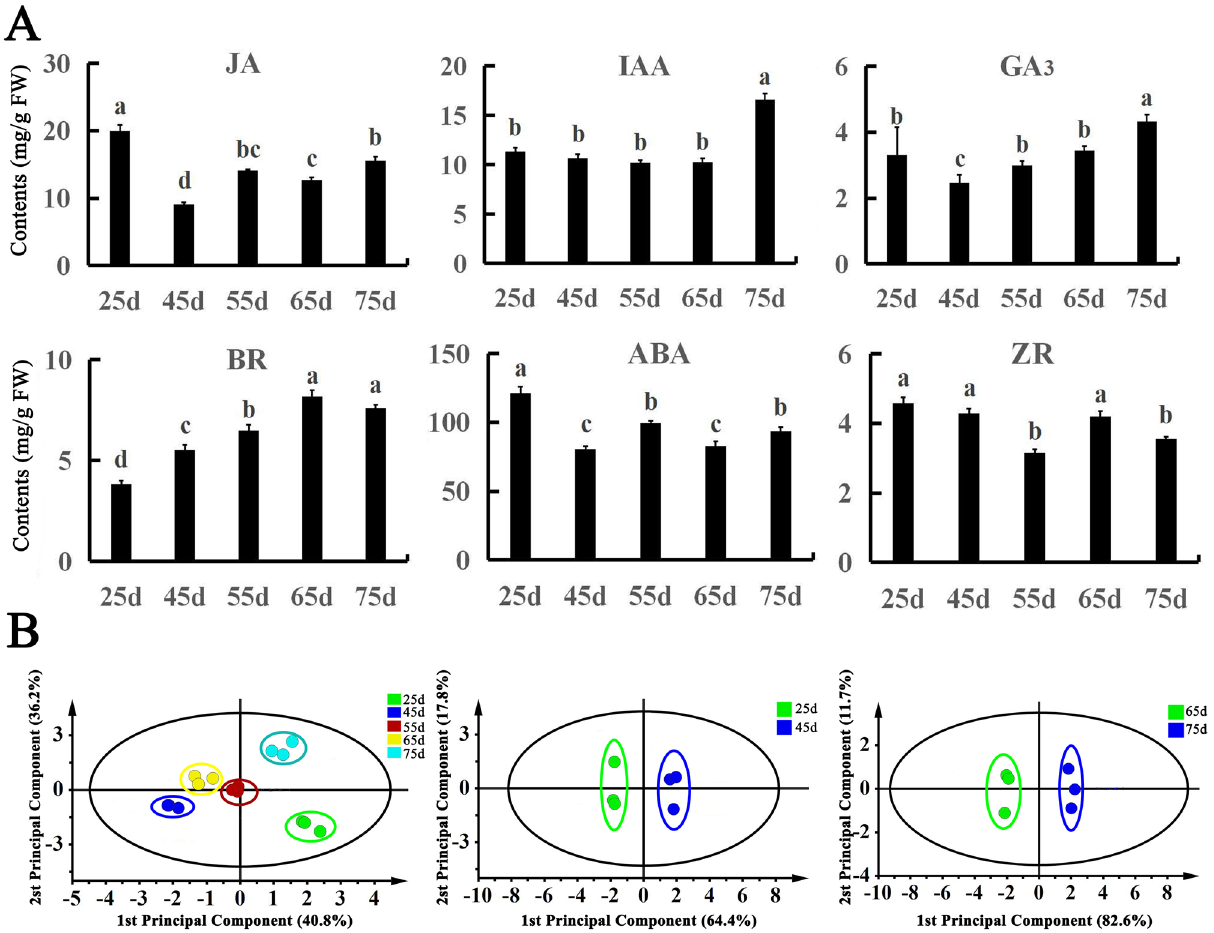
Figure 1. Analysis of endogenous hormone content in callus of O. fragrans at different developmental stages. ( A ) Content of six endogenous hormones in callus of O. fragrans at five developmental stages. ABA abscisic acid, BR brassinosteroids, GA 3 gibberellin, IAA auxin, JA jasmonic acid, ZR zeatin. Different letters denote significant differences according to the Tukey’s test ( P < 0.05). ( B ) Score plot of endogenous hormone content of O . fragrans according to different developmental stages using OPLS-DA